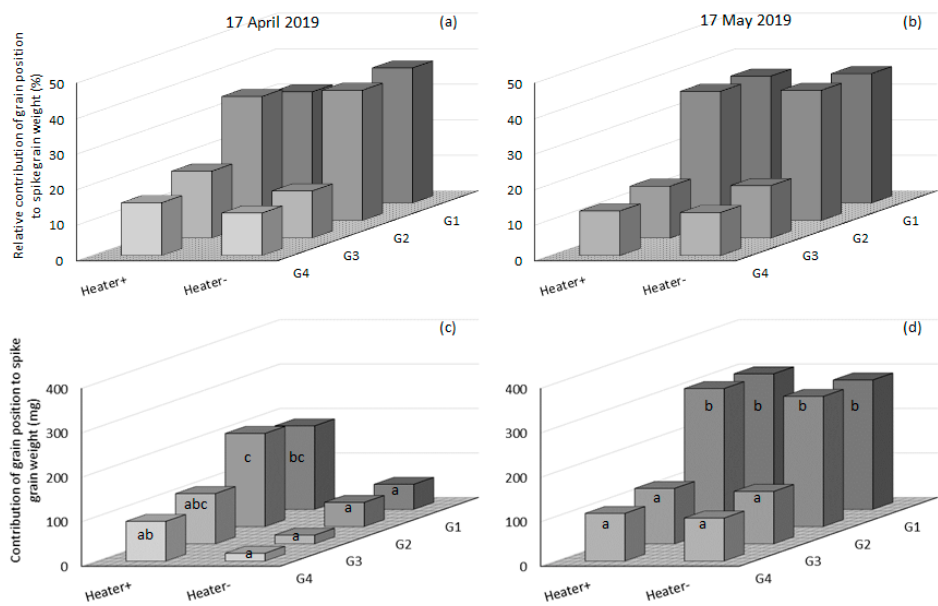
Figure 11. The relative contribution of grain at each position of the spikelet (grain position) to spike grain weight in Wyalkatchem under incidence of frost sown in mid-April (17 April 2019 ( a )) and low incidence of frost mid-May (17 May 2019 ( b )) sampled from heated and non-heated plots. Absolute spike grain weights for the same sowing dates are shown on ( c , d ) with significance ( p < 0.05) noted by different lowercase letters for each sowing date compared separately. Relative contributions are calculated from the predicted means of absolute spike grain weights (n = 45 spikes per data column).